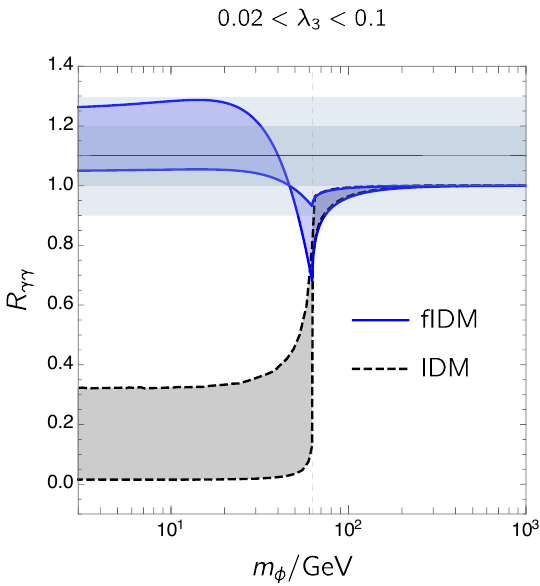
Figure 4 . Predictions for R γγ as functions of the degenerate doublet mass m φ in the fIDM (solid lines) and the IDM (dashed lines). In both cases, the coupling λ 3 varies in the range [0 . 02 , 0 . 1] . The region allowed by present experiments at the 2 σ confidence level is shaded in light blue. Above the threshold, for m φ > m h / 2 , the fIDM and the IDM predictions coincide. Below the threshold, for m φ < m h / 2 , the fIDM values are larger because the total width of the Higgs boson does not receive a tree-level contribution from the production of fakeons.